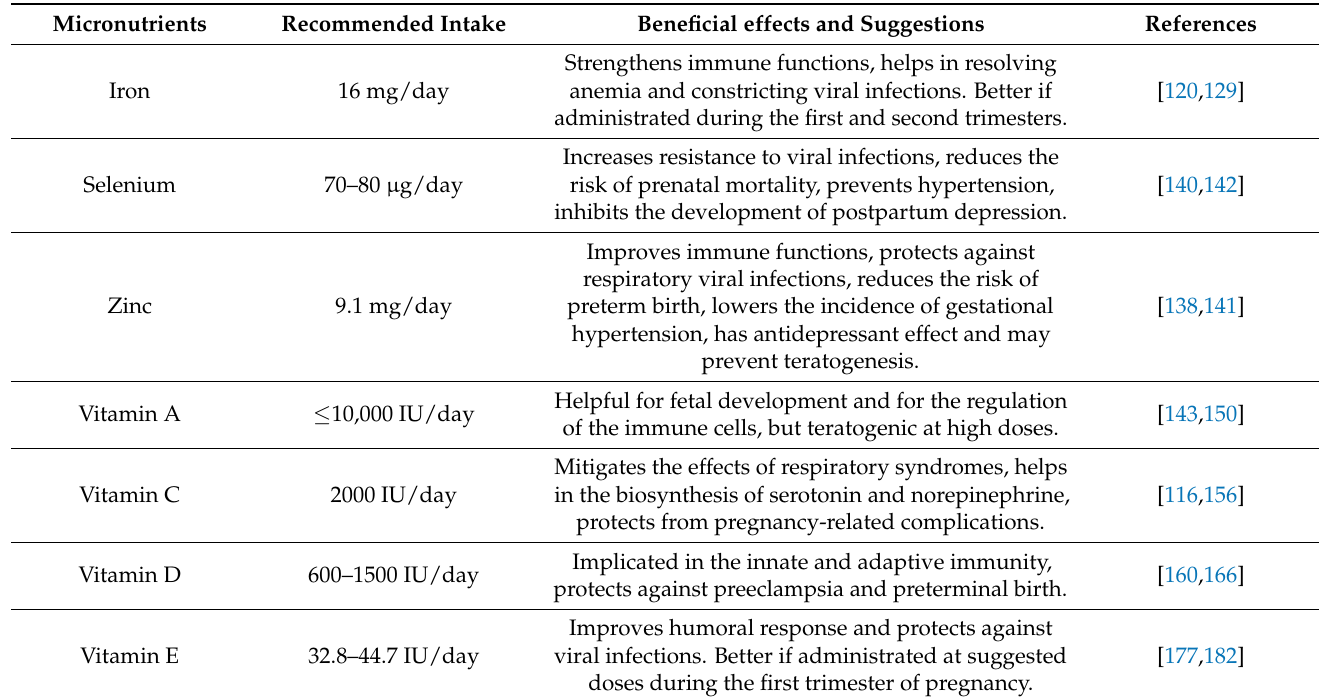
Table 1. Micronutrients helping pregnancy with recommended